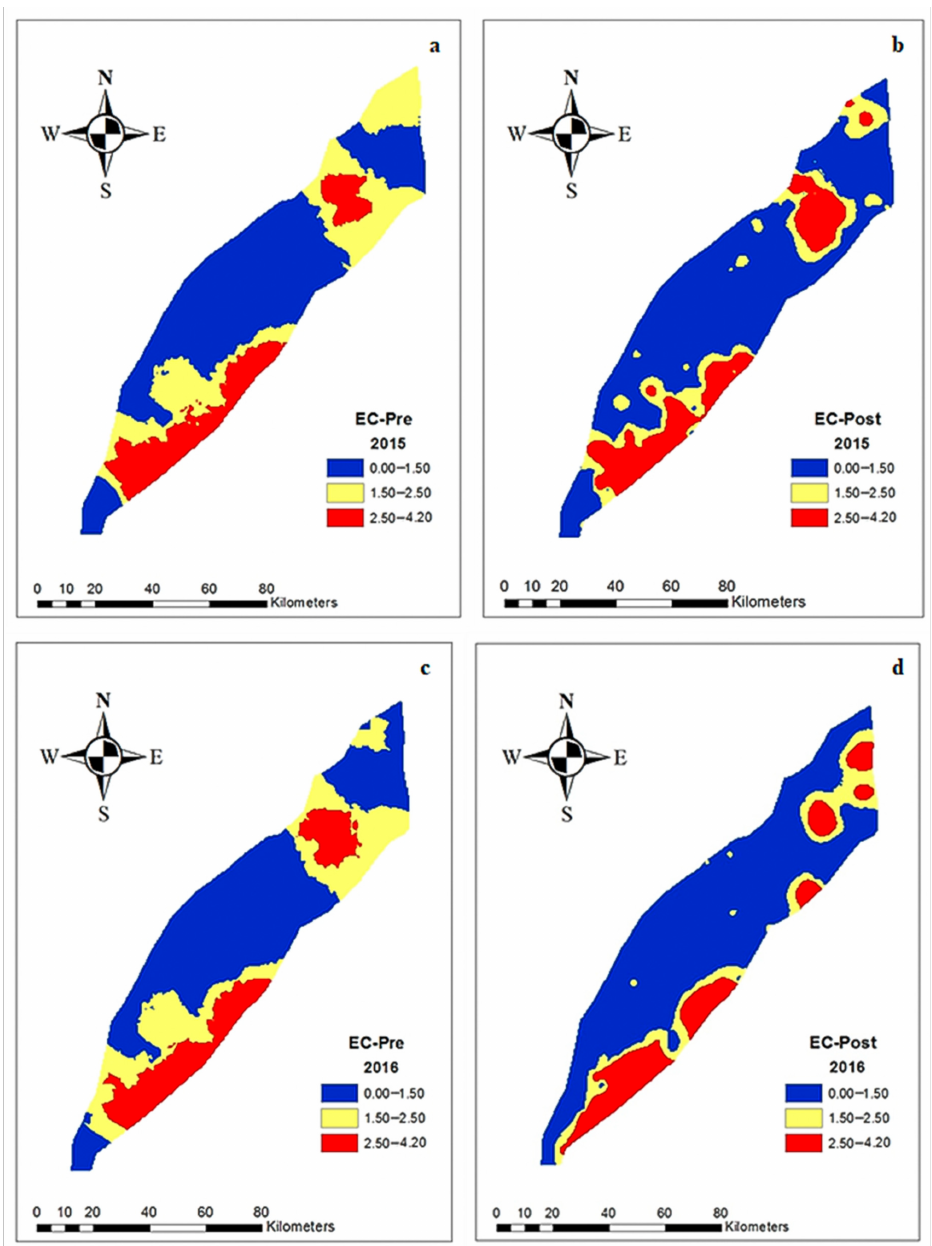
Figure 2. Spatial distribution of groundwater EC (dS / m) ( a ) for pre-monsoon season in 2015 ( b ) for post-monsoon season in 2015 ( c ) for pre-monsoon season in 2016 ( d ) for pre-monsoon season in